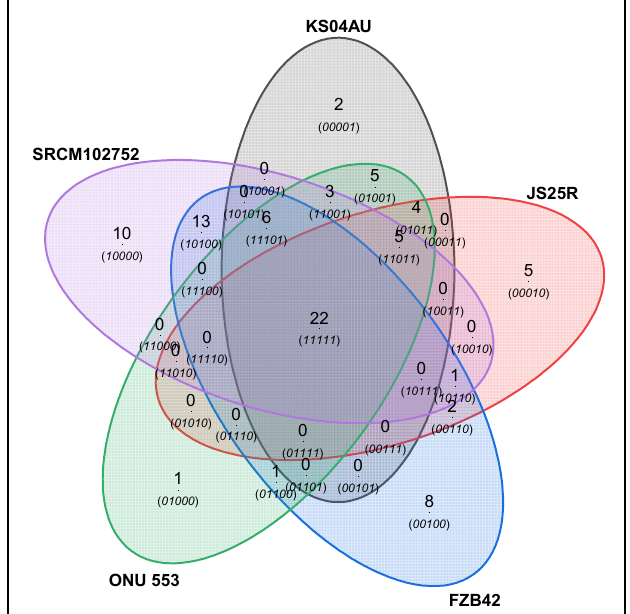
Figure 7. Comparative analysis of mobile genetic elements (IS-Elements) of genome B. velezensis strains KS04AU, JS25R, FZB42, ONU-553, and SRCM102752. Data in italics represent the group number with IS-elements shared between genomes (Table S3).